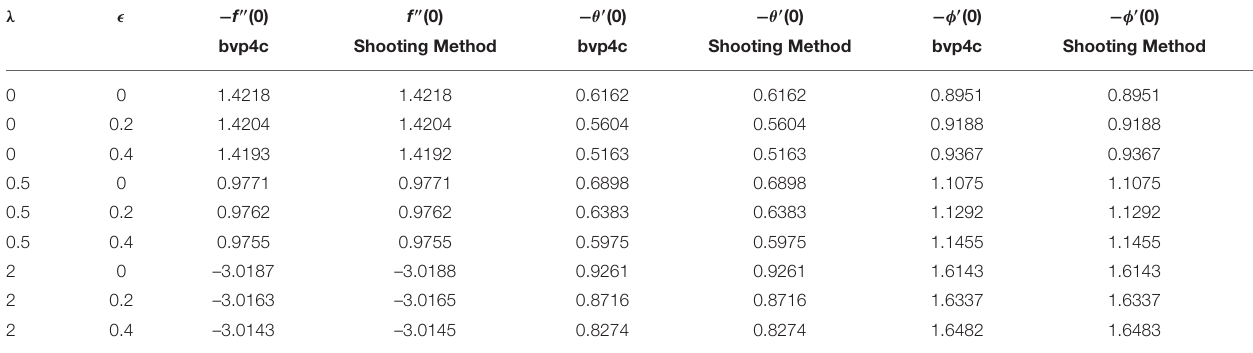
R d λ 0, Pr 0 1, θ r 5, L e 1.3. = = = = = − =